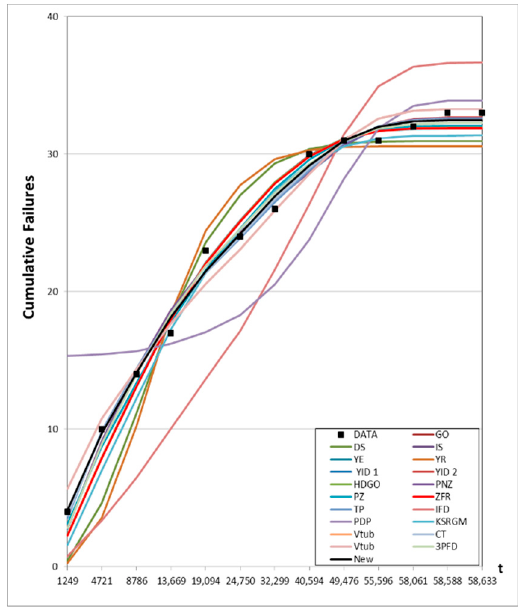
Figure 5. Mean value functions for all models in Table 1 for dataset #2.